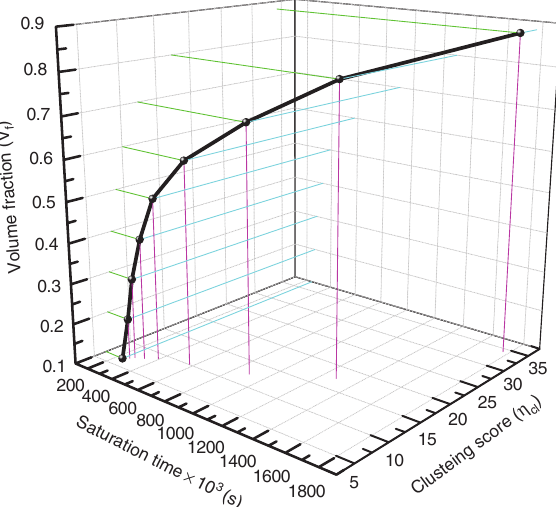
Figure 20: Saturation duration and clustering scores across volume Figure 18 shows the fraction of saturated area meas- ured at different time steps for different fiber volume frac- tions. Four different microstructures are evaluated for each volume fraction in order to get a statistically averaged satu- ration time response. Hence, 32 different microstructures were simulated for eight different fiber volume fractions.